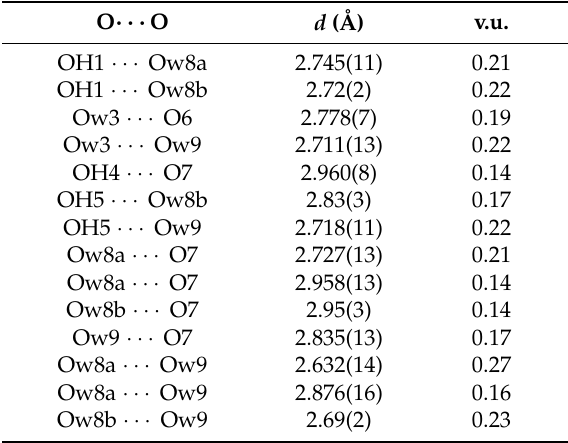
Table 7. O · · · O distances (in Å) and corresponding bond strengths (in v.u.) in tiberiobardiite, calculated according to